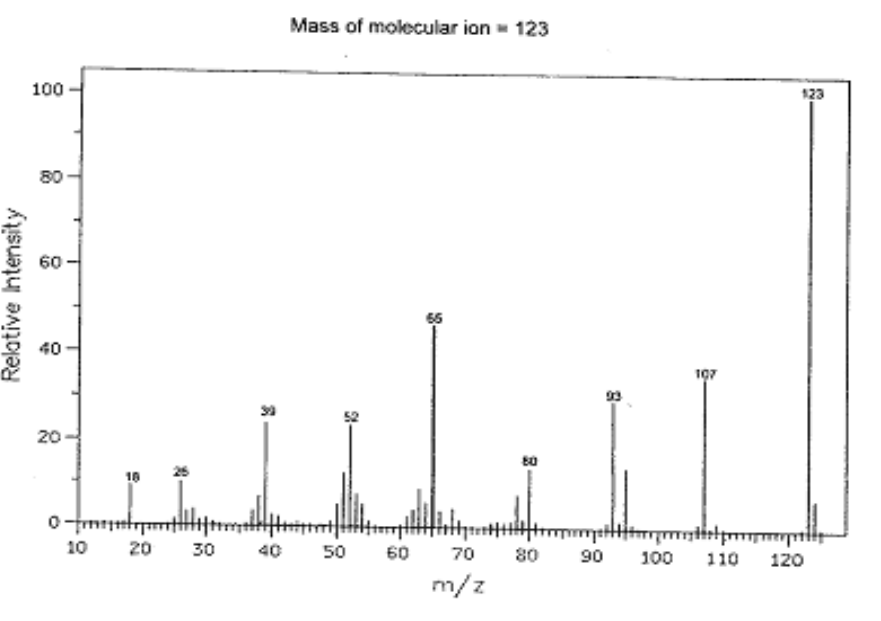
Figure 1. GC- Mass Spectrum of Quinone Oxime with its molecular ion peak at 123 Reaction